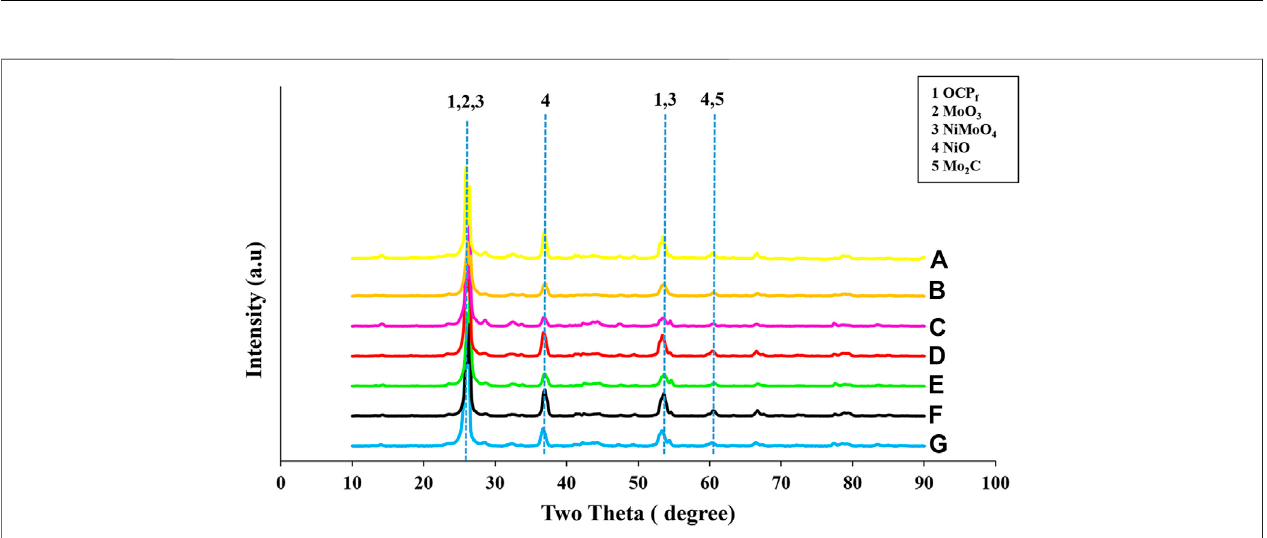
FIGURE 4 | High angle XRD patterns of OCP f -supported NiMo catalysts (A) 5.0wt%Ni26wt%Mo/OCP f (B) 5.0wt%Ni19wt%Mo/OCP f (C) 5.0wt%Ni13wt%Mo/